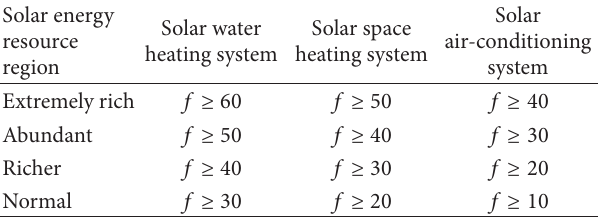
Table 1: Requirement for the solar energy fraction in different solar energy resource regions.